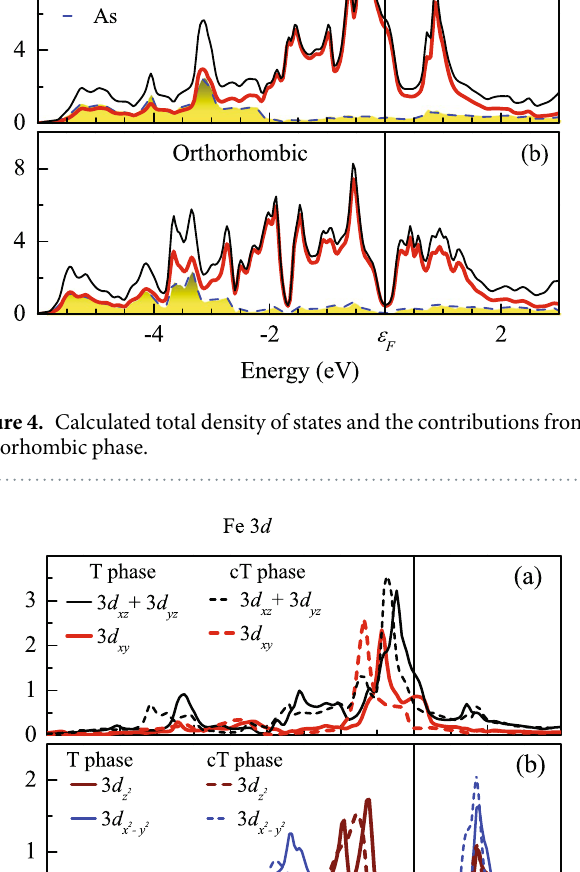
and − d 3 states are shown by thick maroon line and thin blue line, z 2 x y 2 2